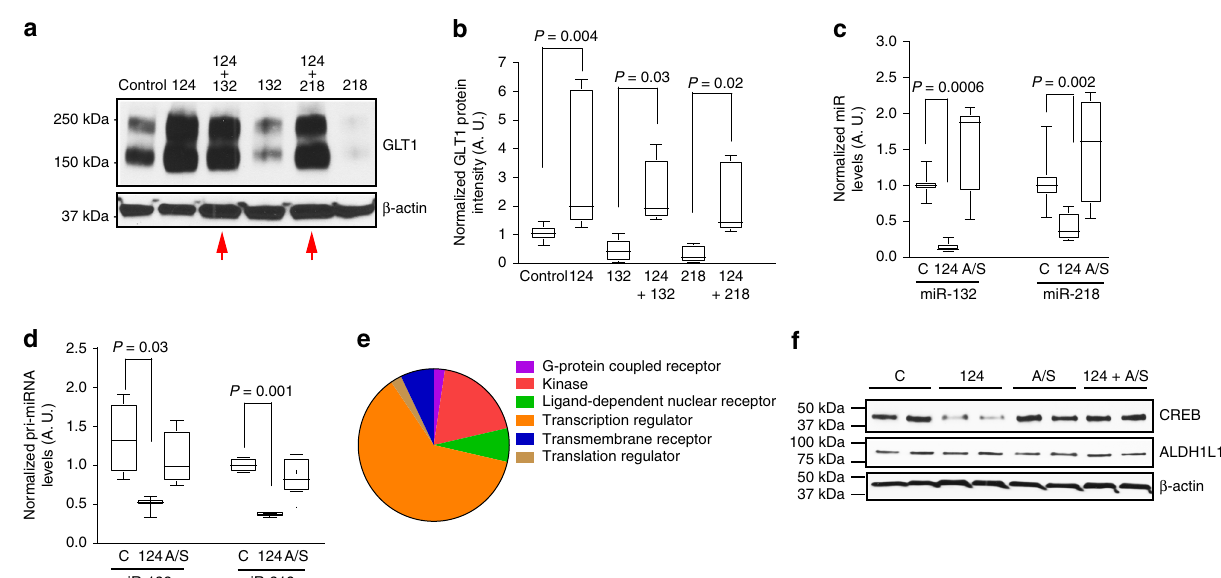
Fig. 9 MiR-124-3p increases GLT1 expression by suppressing GLT1-inhibiting miRs in astrocytes. Representative GLT1 immunoblot ( a ) and quanti fi cation ( b ) following transfection of individual miRs (miR-124, miR-132, or miR-218) or co-transfection of miR-124-3p/miR-132 or miR-124-3p/miR-218 mimics in astrocyte cultures. n = 6 – 8 independent transfections per condition. P- values were determined from one-way ANOVA and post hoc Tukey ’ s test. Levels of miR-132 and miR-218 ( c ) and pri-miR-132 and pri-miR-218 ( d ) in astrocyte cultures following miR-124-3p transfection. n = 9 independent transfections per condition. β -actin mRNA was used as endogenous control for quanti fi cation of pri-miR-132. P- values were determined using one-way ANOVA and post hoc Tukey ’ s test. e Pie chart showing functional categories of genes that are expressed in astrocytes and are also predicted miR-124-binding targets. TargetScan was used to identify putative miR-124-3p target mRNAs. Ingenuity pathway analysis (Qiagen) was used for characterizing functional categories. Only genes that are expressed in both human and mouse astrocytes (FPKM > 10, mouse and human 42 and have at least two predicted miR-124- 3p-binding sites were included in generating the pie chart. f Representative Creb1 immunoblot from primary astrocytes following transfection with miR- 124-3p and miR-124 antisense. The data was presented in the box and whisker plot with de fi ned elements, median (center line), upper and lower quartiles (bounds of box), and highest and lowest values